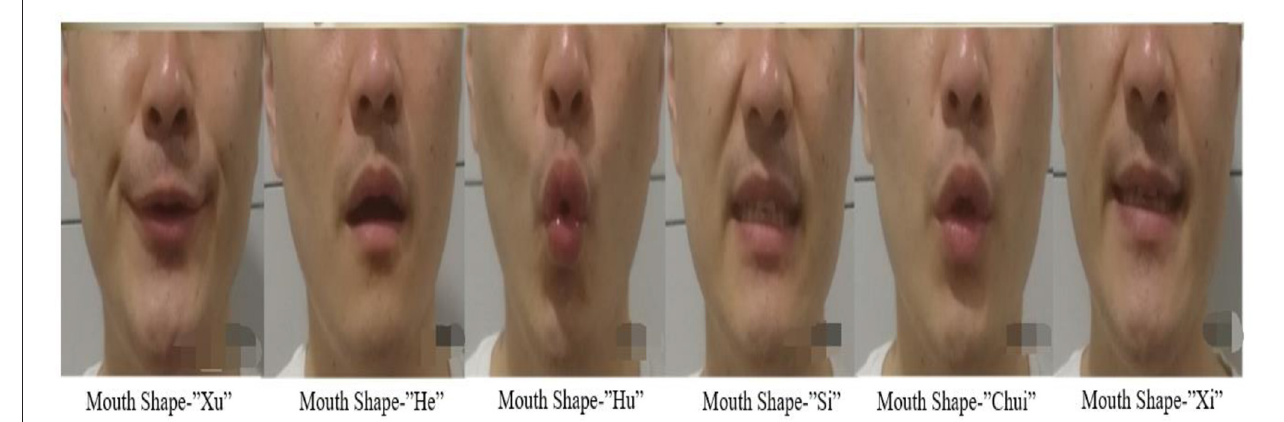
FIGURE 2 | The mouth shape of LQG. It shows the pronunciation of the six characters of LQG: as follows: “Xu” and “Si” for the alveolar sound, “He” and “Xi” for the lingual sound, “Hu” and “Chui” for the labial